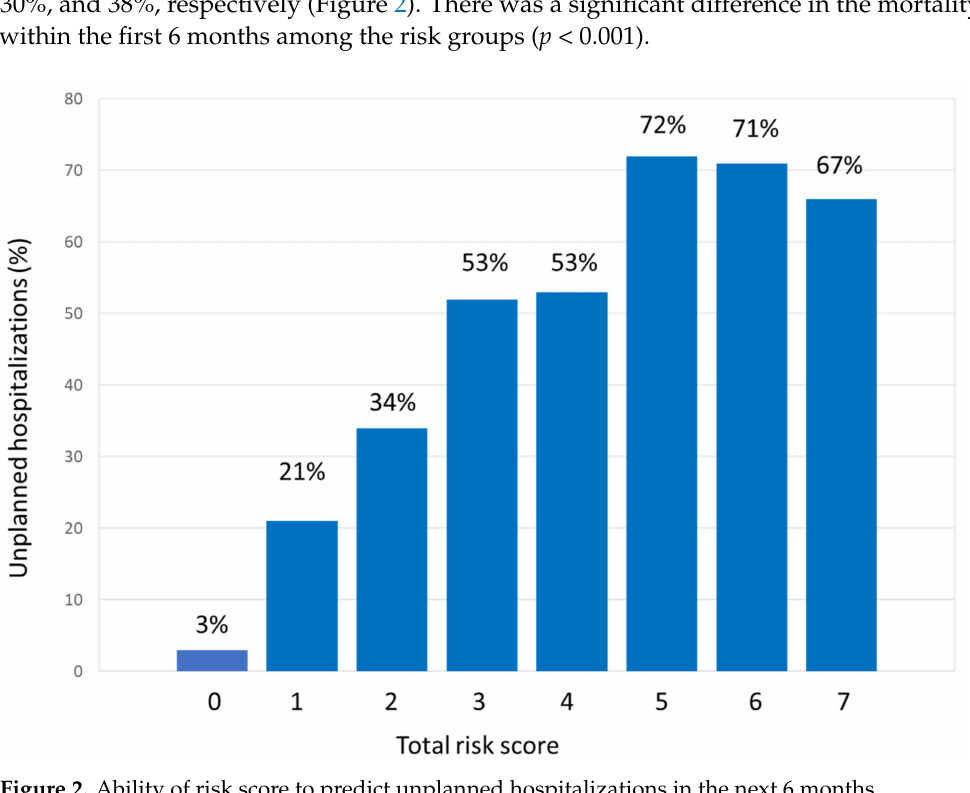
Figure 2. Ability of risk score to predict unplanned hospitalizations in the next 6